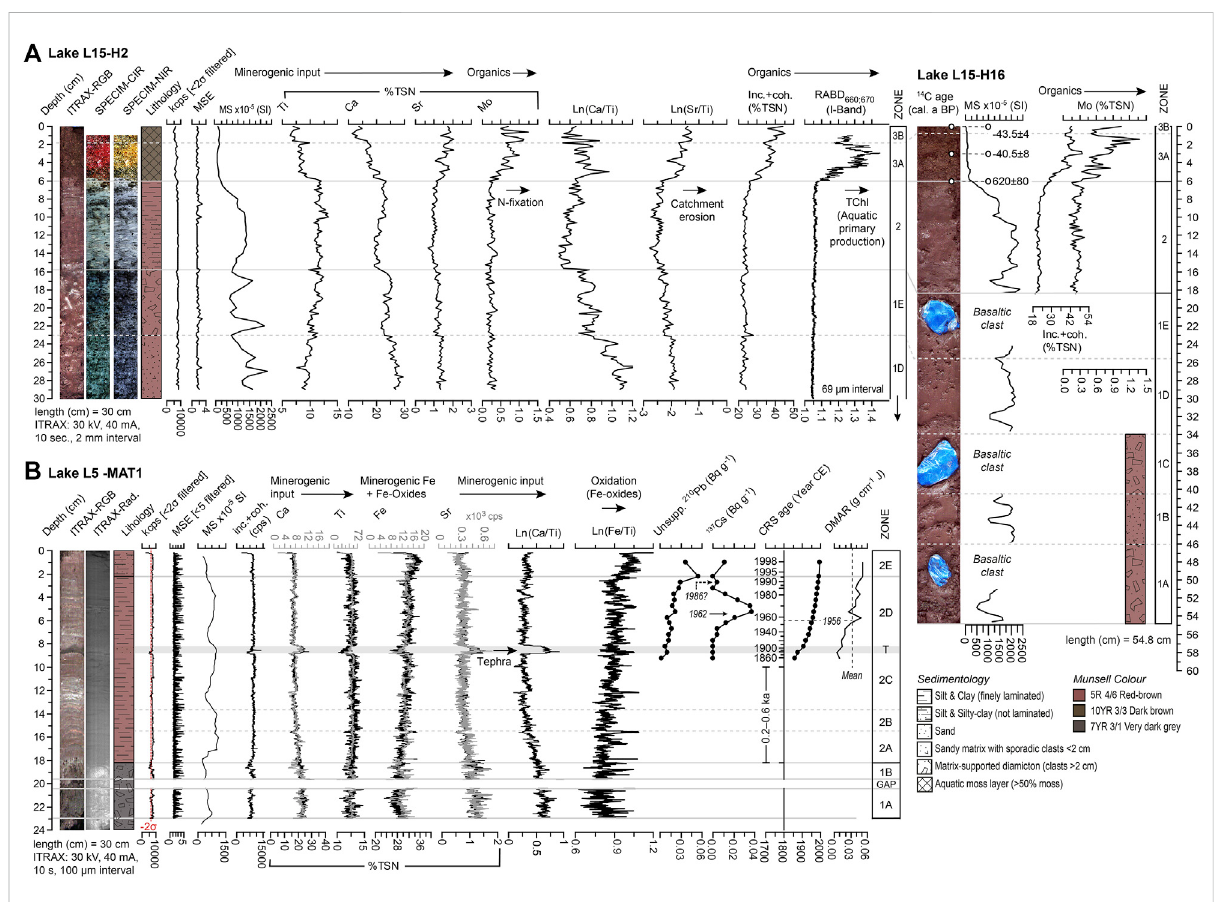
FIGURE 7 Summary lithological, ITRAX XRF-CS, SPECIM hyperspectral imagery and data, and chronological data from sediment records from (A) Lake L15 and (B) Matias Lake (ML; L5). A positive correlation between the RABD660;670 (re fl ecting increased organic productivity) and the XRF-CS molybdenum (Mo) and total scatter pro fi les in Lake L15 exists because Mo improves the ef fi ciency of nitrogen fi xation and the nitrogenase creation process by binding with organic ligands (e.g., tannins) in near-surface and sub-aquatic environments (including freshwater moss) and iron oxides and organic matter at depth, preventing it from leaching out of the sediment (Wichard et al., 2009). Conversely, Mo has very low concentrations in mineral-rich sediments as Mo attachment to mineral grains is an insigni fi cant process. Total scatter (inc. + coh.) and scatter ratios (inc./coh.) are also elevated in organic matter as it is less dense and has a higher water content than minerogenic sediments (Davies et al.,